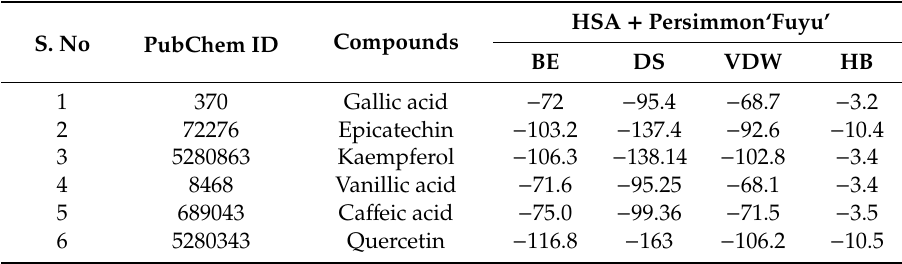
Table 4. The ligands from persimmon ‘Fuyu’ showing interaction with HSA represented with binding energy (BE), dock score (DS), van der Waals (VDW) and H-bond (HB)